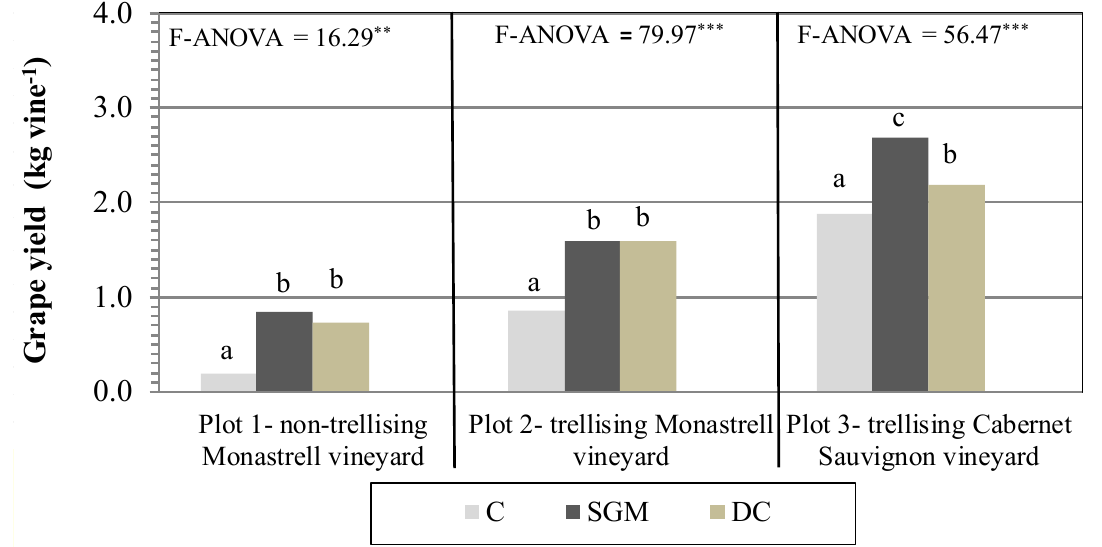
Figure 5. Grape yield per vine. In each plot, bars with the same letter are not significantly different at p < 0.05 (Tukey-b test). ** and ***: significant at p < 0.01 and 0.001, respectively. (C: control, SGM: sheep/goat manure and DC: distillery organic waste compost).